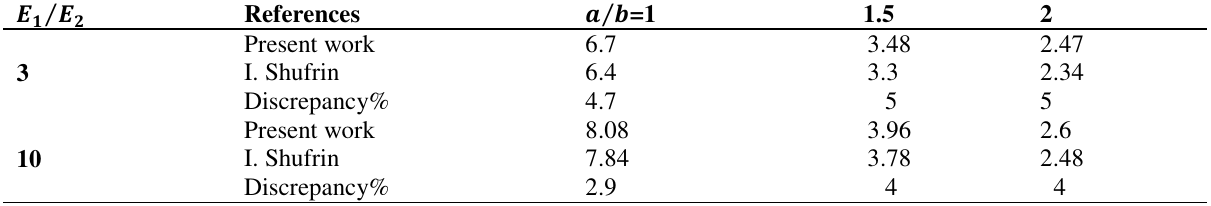
Non-dimensional buckling load modulus ratio, (